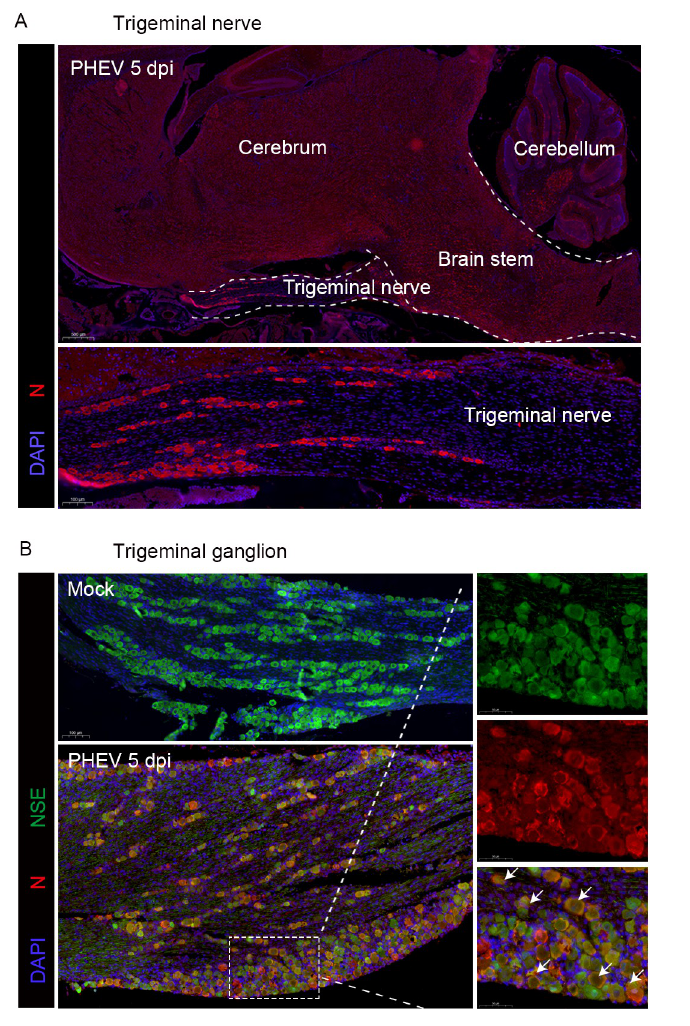
Fig 7. The trigeminal nerve is an alternative route for PHEV neuroinvasion. The 3w BALB/c mice were inoculated with 10 3.96 TCID 50 PHEV by the intranasal route and sacrificed at 5 dpi. (A) Brains from PHEV-infected mice were subjected to immunofluorescence staining using a PHEV-N antibody (red). A magnified image of the trigeminal nerve is shown in the lower panel. (B) Trigeminal ganglions of mock- and PHEV-infected mice were immunofluorescence stained using NSE (green) and PHEV-N (red) antibodies. The right three panels represent magnified images of the area delimited by the dotted box. Arrows indicate cells colocalized with NSE and PHEV-N. DAPI stains nuclei (blue). NSE, neuron-specific